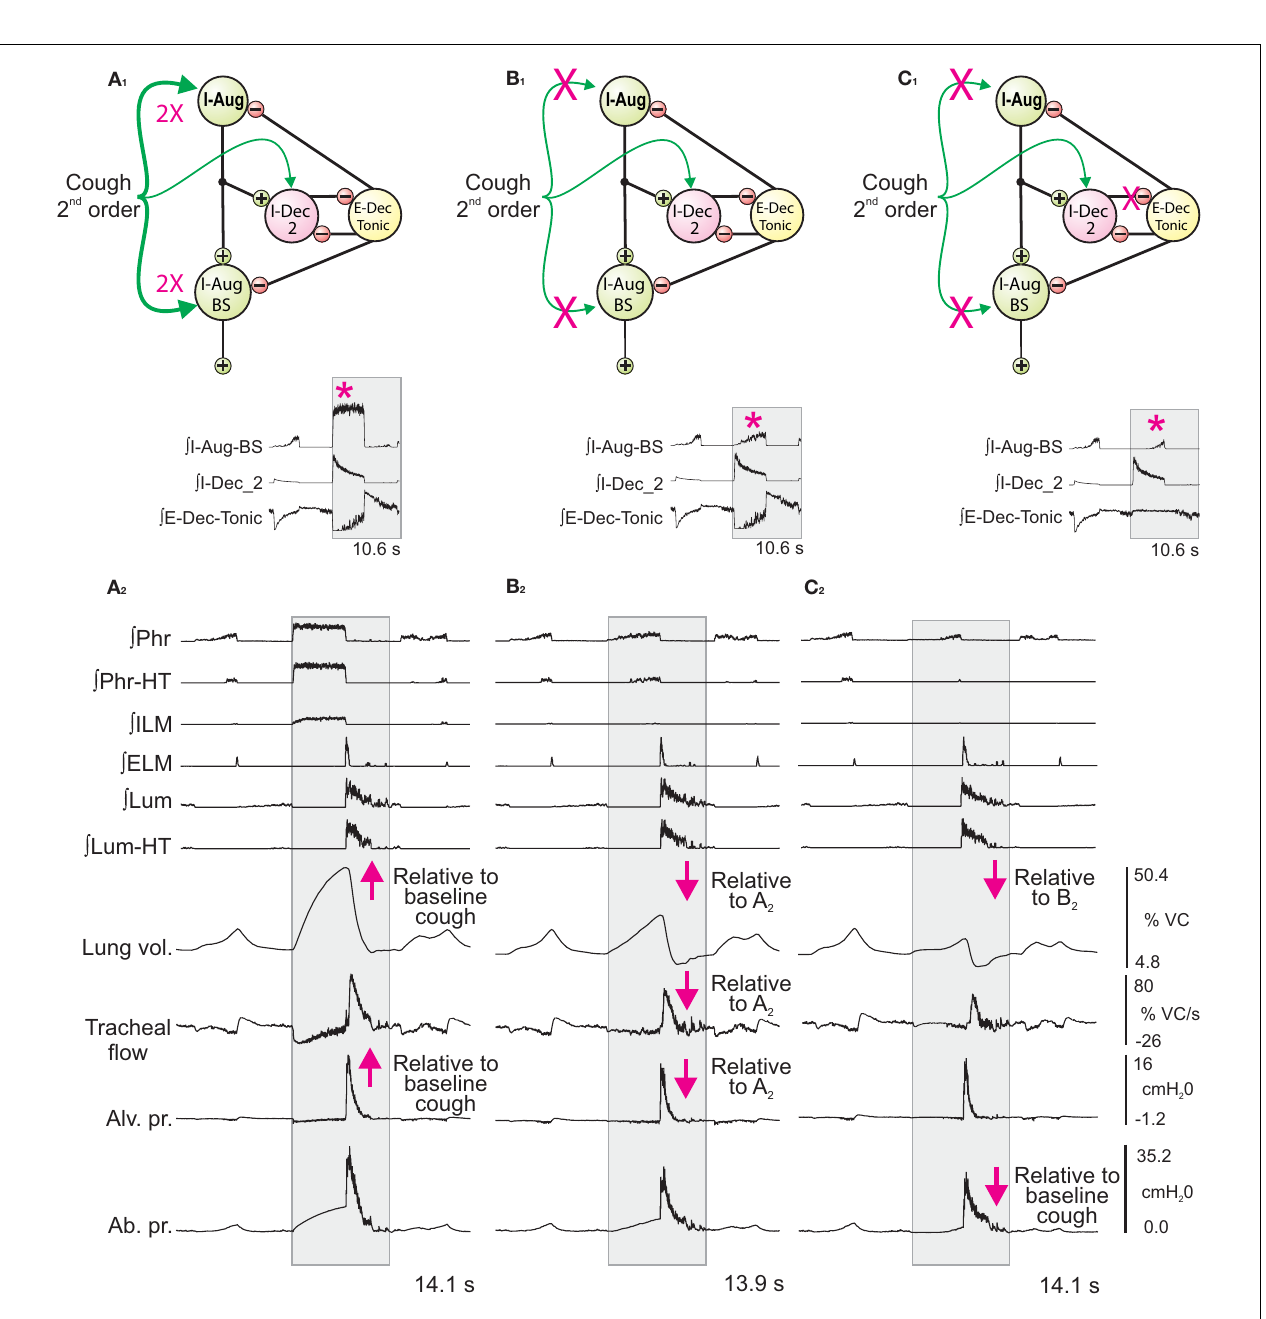
stimulation relative to the baseline conditions represented in and described for Figure 3A . Corresponding panels ( A 2 –C 2 ) show integrated traces of motor neuron population activities and biomechanical model outputs (left labels) for the respective perturbations of inspiratory drive. Arrows mark changes. See text for further